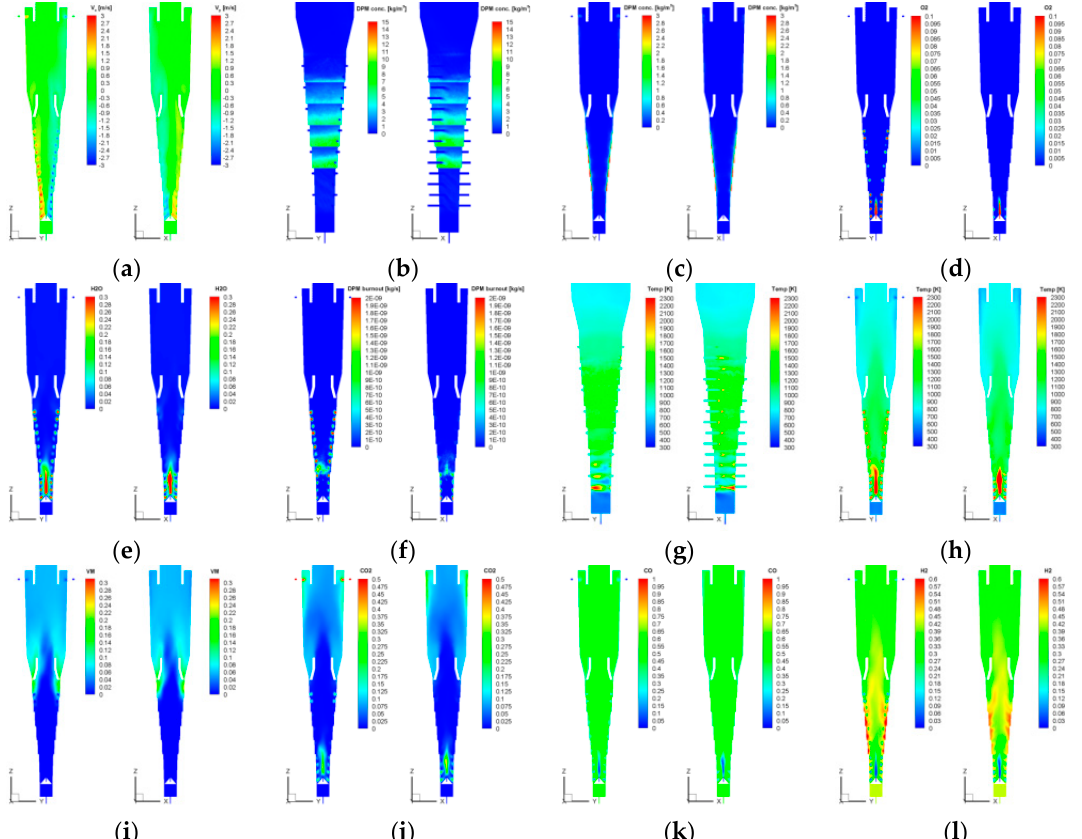
Figure 2. Distributions of selected process parameters during fuel gasification in the cyclone furnace for the variant A1 (O 2 /H 2 O, 60/40): ( a ) peripheral speed, ( b ) fuel content on the internal walls, ( c ) fuel content in the cross-section, ( d ) content of O 2 , ( e ) content of H 2 O, ( f ) fuel combustion rate, ( g ) temperature on the walls, ( h ) temperature in the vertical section, ( i ) volatile matter content, ( j ) content of CO 2 , ( k ) content of CO, ( l ) content of H 2